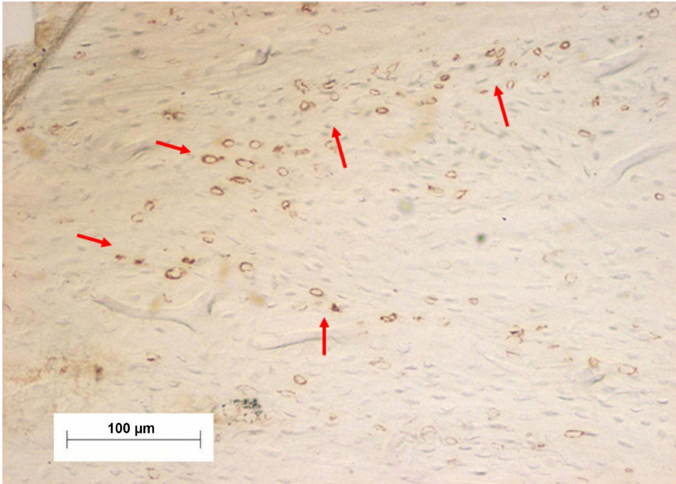
Figure 1. Image showing red arrows where there were positive immunohistochemical reactions (NF- κ B labelling) of cells (brown